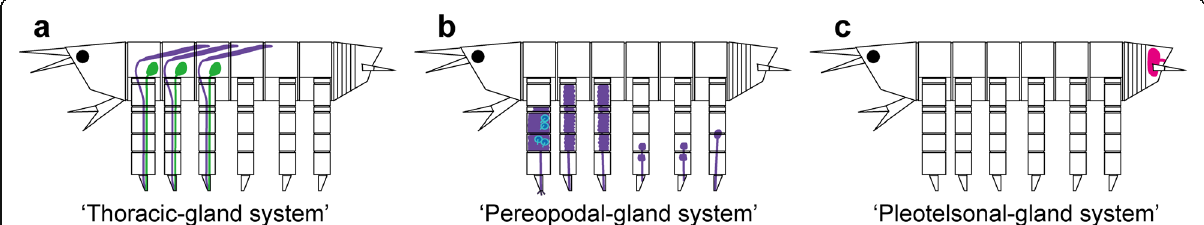
Fig. 6 Schematic drawings of secreting systems in Tanaidacea. a Thoracic-gland system in Sinelobus sp., after [9]; tg1 and tg2 are shown in purple and green, respectively. b Pereopodal-gland system in Phoxokalliapseudes tomiokaensis (Shiino, 1966), after [11]; large rosette glands and lobed glands are shown in blue and purple, respectively. c Pleotelsonal-gland system in P. algicola ; position of paired glands are shown in